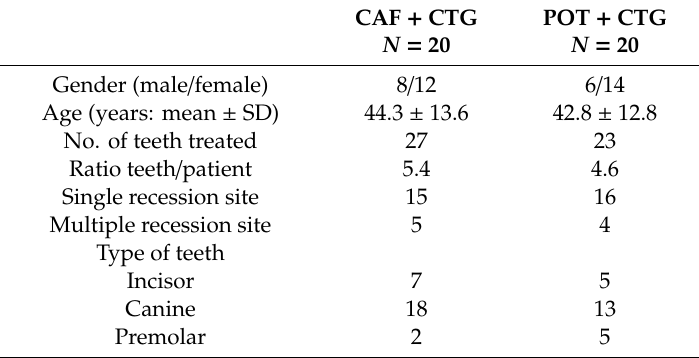
Table 1. Patient demographics and site-related characteristics at baseline in control and test